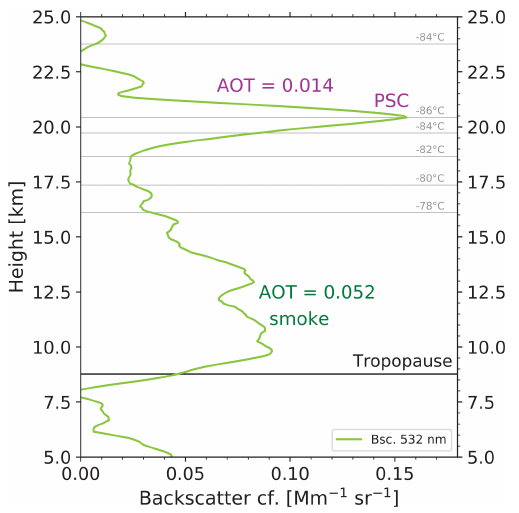
Figure 17. Polar stratospheric cloud (PSC) from 18 to 22.5km height on top of the smoke layer on 15 January 2020, 22:30– 23:30UTC. The 532nm particle backscatter coefficient is shown, and the AOT values for the smoke (computed from the backscat- ter values multiplied by a lidar ratio of 85sr) and of the PSC layer (computed from the backscatter values multiplied by a lidar ratio of 50sr) are given as numbers. Horizontal grey lines show different temperature levels. Tropopause was at 8.8km height.